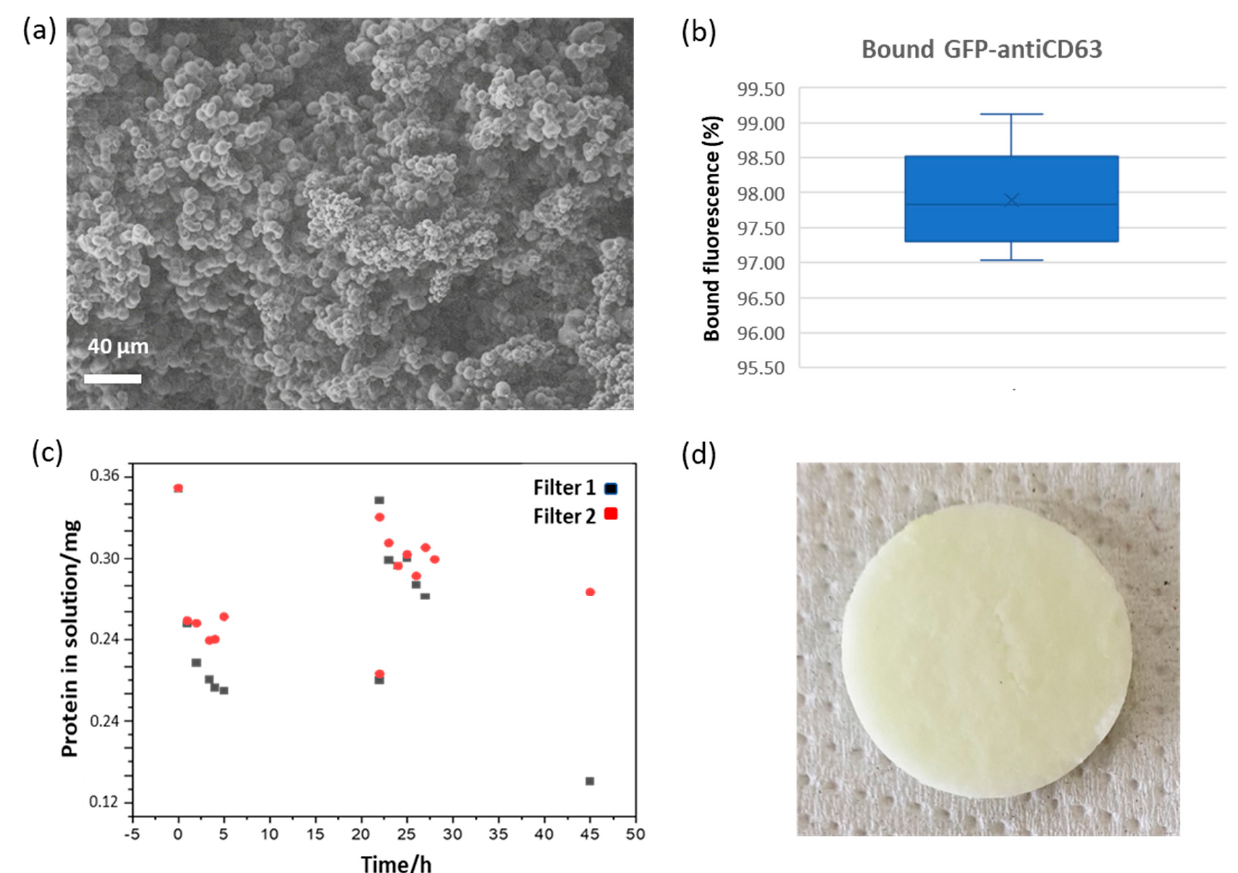
Figure 1. Monolith filter characteristics and its binding features. ( a ) Scanning electron microscope (SEM) imaging of an epoxy monolith disc. ( b ) Binding efficiency of the sandwich between anti-green fluorescent protein (GFP) nanobody and GFP-anti-CD63 nanobody. The data correspond to five independent experiments. ( c ) Evaluation of the binding capacity of the monolith filter. Fluorescent protein was circulated into the column until no apparent further binding was measured. Then, another aliquot of the concentrated solution was added and the protocol repeated. Two independent experiments are reported. ( d ) Macroscopic picture of the filter functionalized with eGFP (note the pale greenish